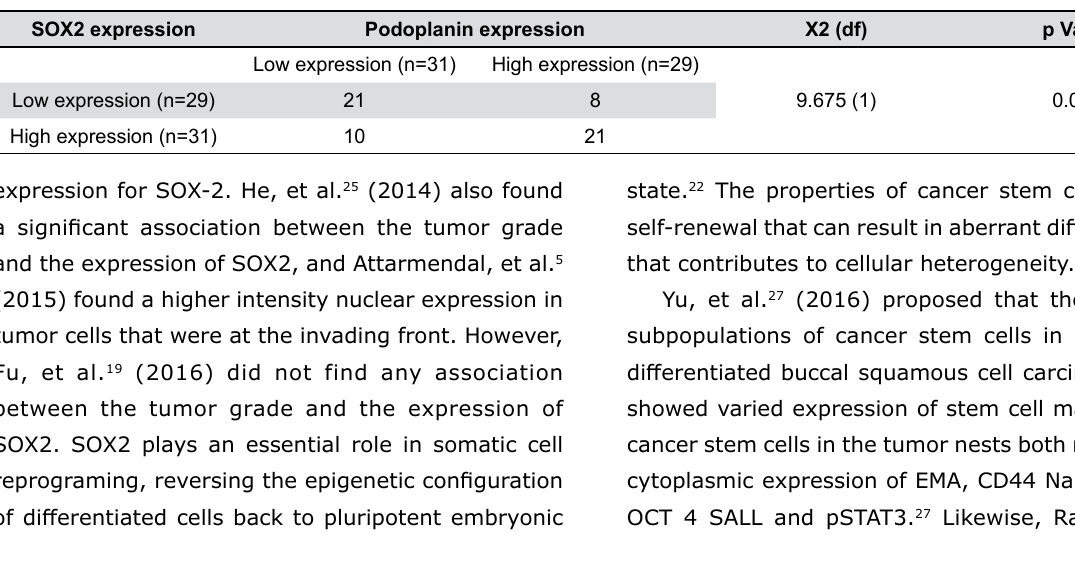
Table 3- Association of the expression of SOX2 with the expression of